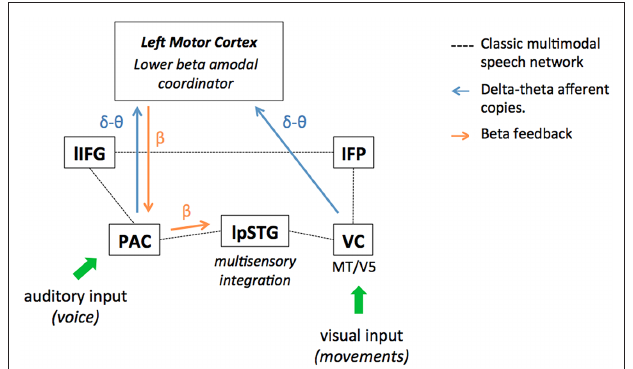
FIGURE 1 | Multimodal speech perception improvement by non-verbal information in the lower motor beta oscillatory framework. The figure represents the classic left-lateralized audiovisual speech perception network and its interactions with the left motor areas in a lower beta oscillation framework. Visual and auditory sensory input is processed separately in the modality-specific visual (VC) and primary auditory cortices (PACs). Then, sampled auditory and visual input reach the secondary auditory cortex the left post superior temporal gyrus (lpSTG), where multimodal integration mechanisms engage in speech perception (which may extend to the left Inferior Parietal lobule (IFP) considered as a multisensory integration site in audiovisual speech). Finally, multimodal information is conveyed to the left inferior frontal gyrus (lIFG) for semantic integration and multimodal semantic binding. In the oscillatory framework, the visual cortex tracks non-verbal information translating the speech envelope structure conveyed at different time scales: mouth and jaw apertures convey syllabic information at theta rate ( ∼ 4 Hz), while other body parts reflect the prosodic features of the speech envelope at 1–3 Hz delta rate (i.e., pitch accents, amplitude, duration, silences, etc.). In the primary auditory cortex, the delta and theta